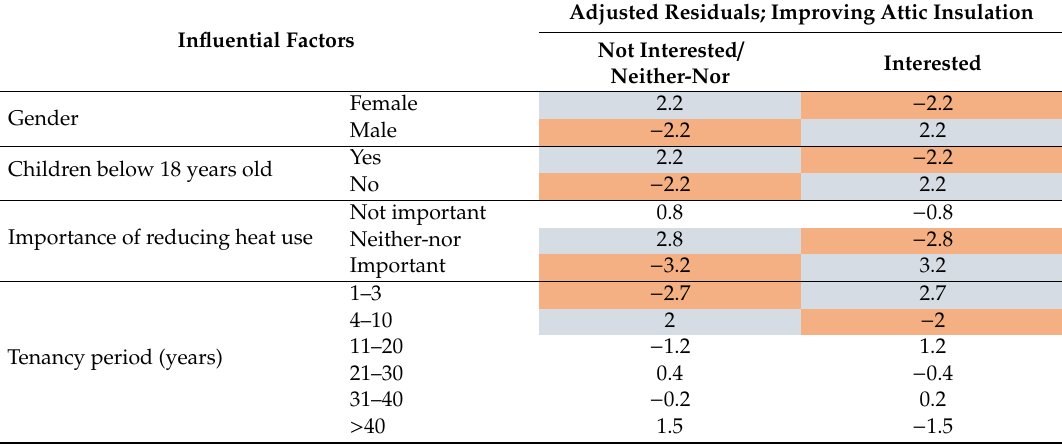
Table A2. Post-hoc analyses of influential factors on homeowners’ interest to improve attic